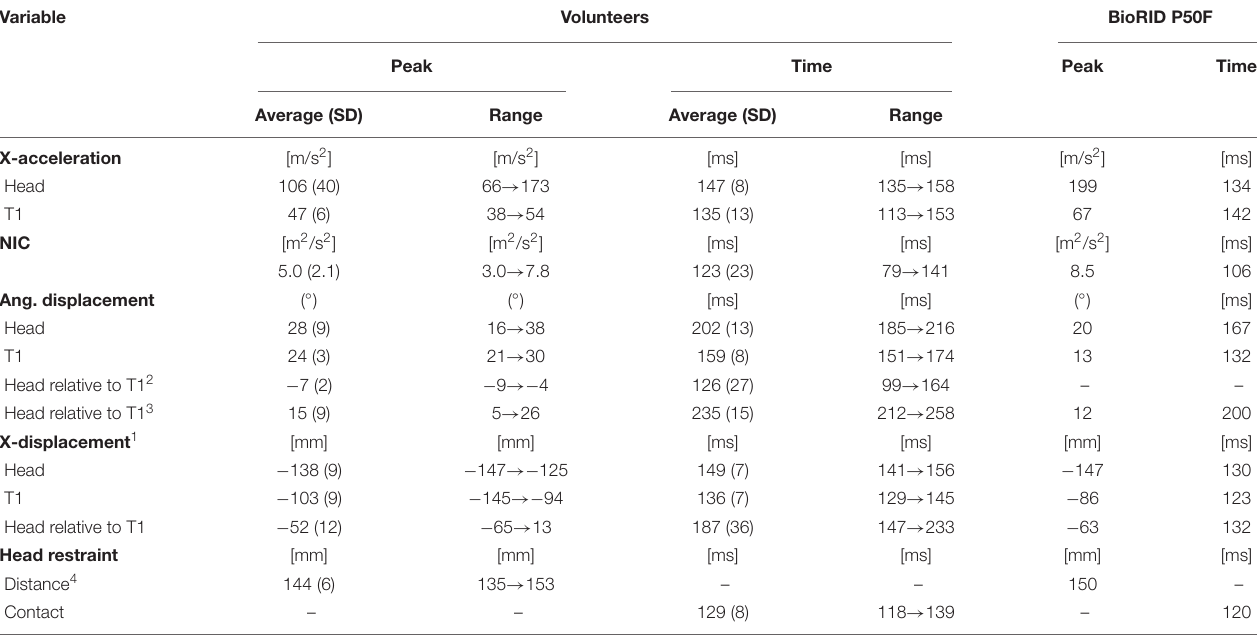
TABLE 2 | Summary of results obtained in the sled test with the BioRID P50F prototype compared with those of female volunteers.